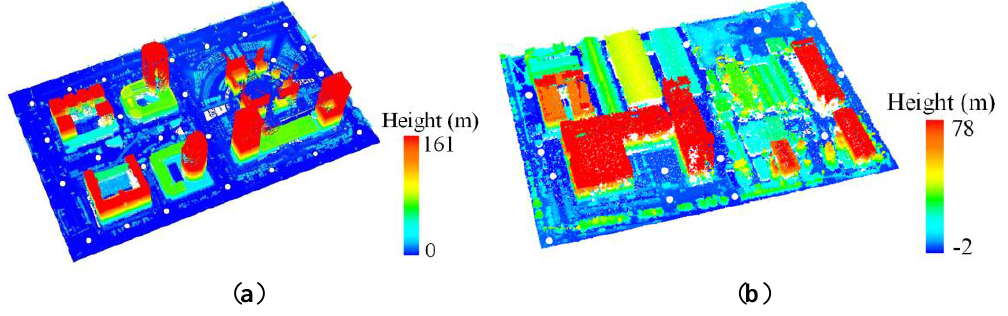
Figure 13. Location of common ground points. ( a ) Common ground points of Area A ; ( b ) Common ground points of Area B .